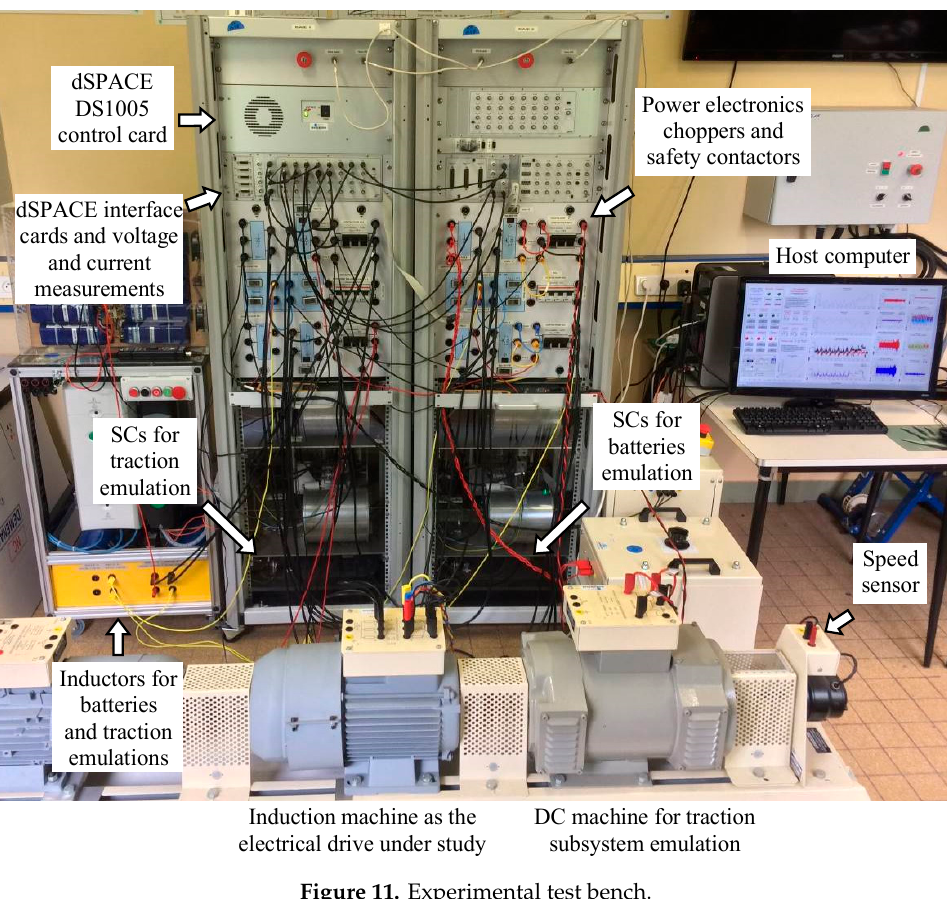
Figure 11. Experimental test bench.